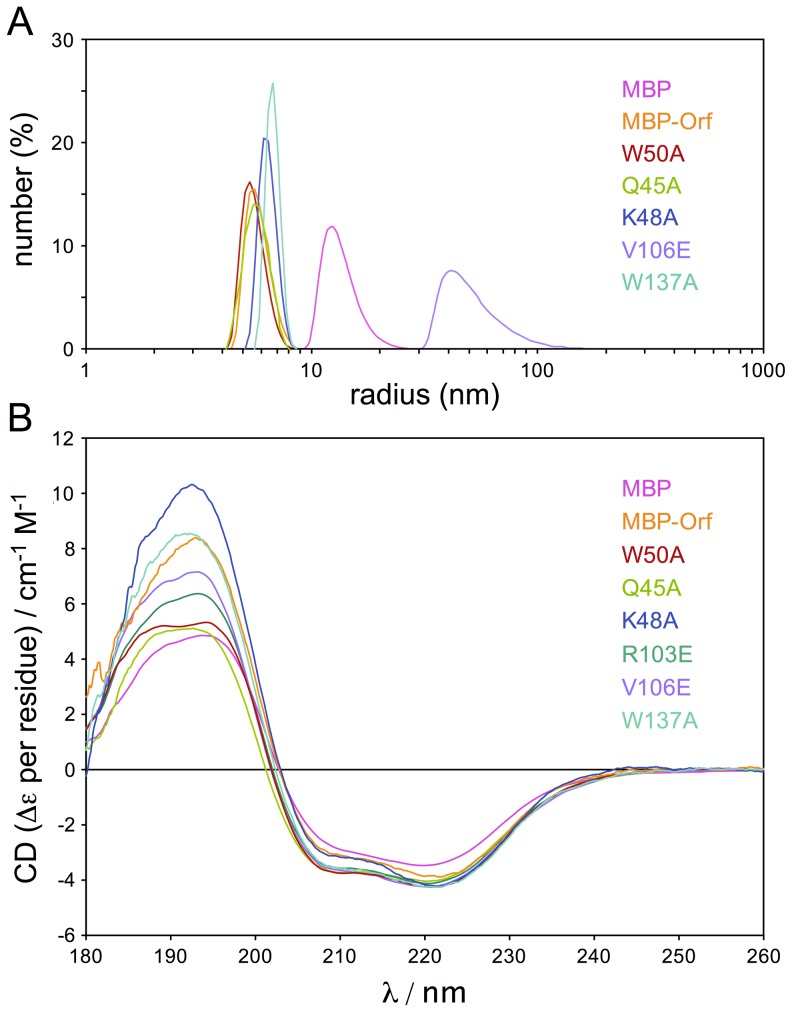
CD spectra and SLS analysis of MBP-Orf mutant proteins.(A) SLS analysis of selected MBP-Orf mutant proteins. Proteins at 0.2 mg/ml in 100 mM Tris-HCl pH7 at 25°C were analyzed in a Zetasizer µV. (B) CD analysis of MBP-Orf mutant proteins. CD spectra (180-260 nm) were obtained for MBP-Orf proteins in ultrapure water at 20°C and analysis performed using CDSSTR, Contin/LL and Selcon3 programs from the CDPro suite [54].